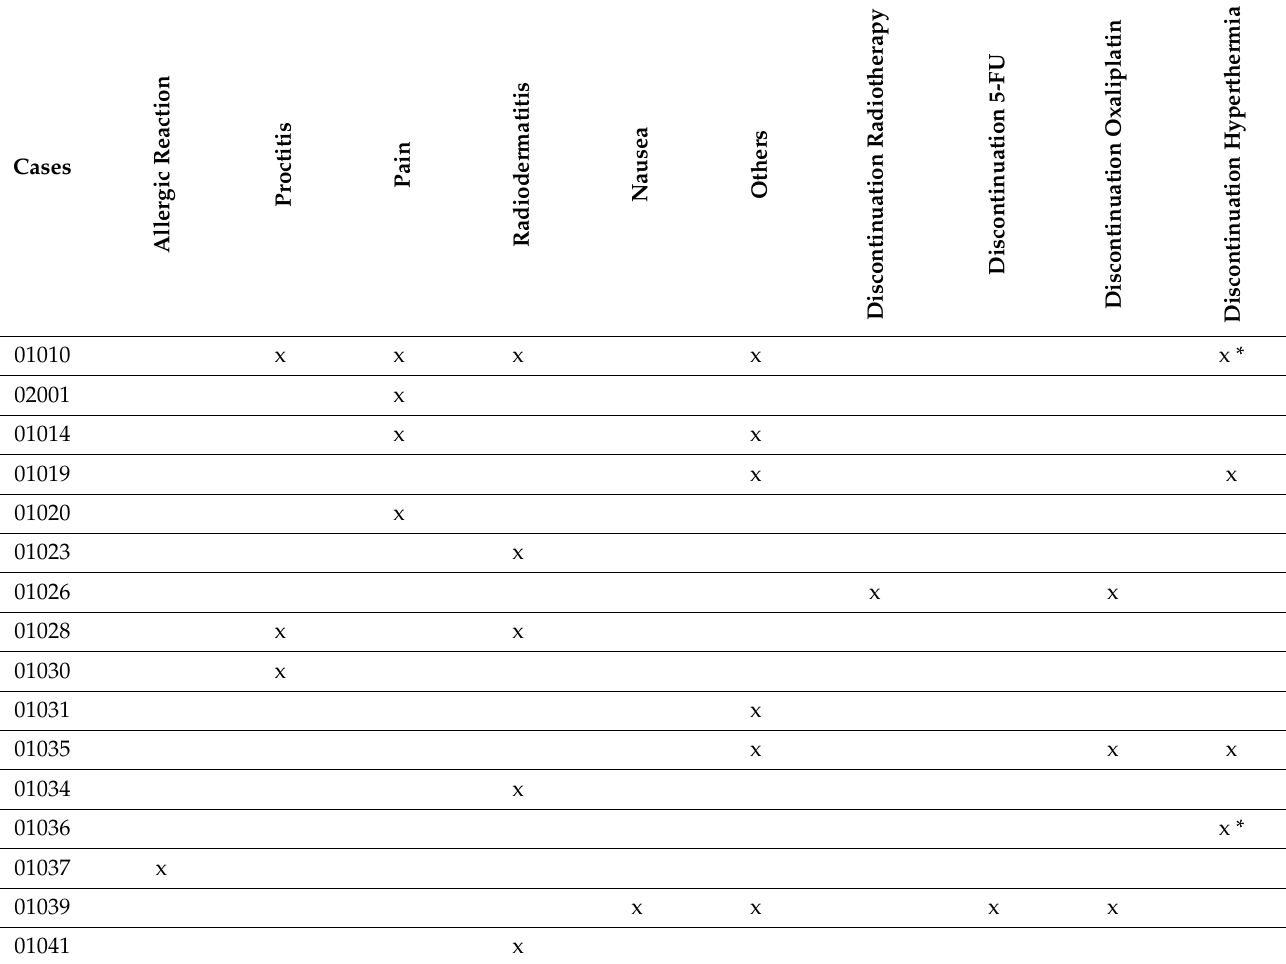
Table 3. Table 2. Case-related dose-limiting toxicities (DLT).